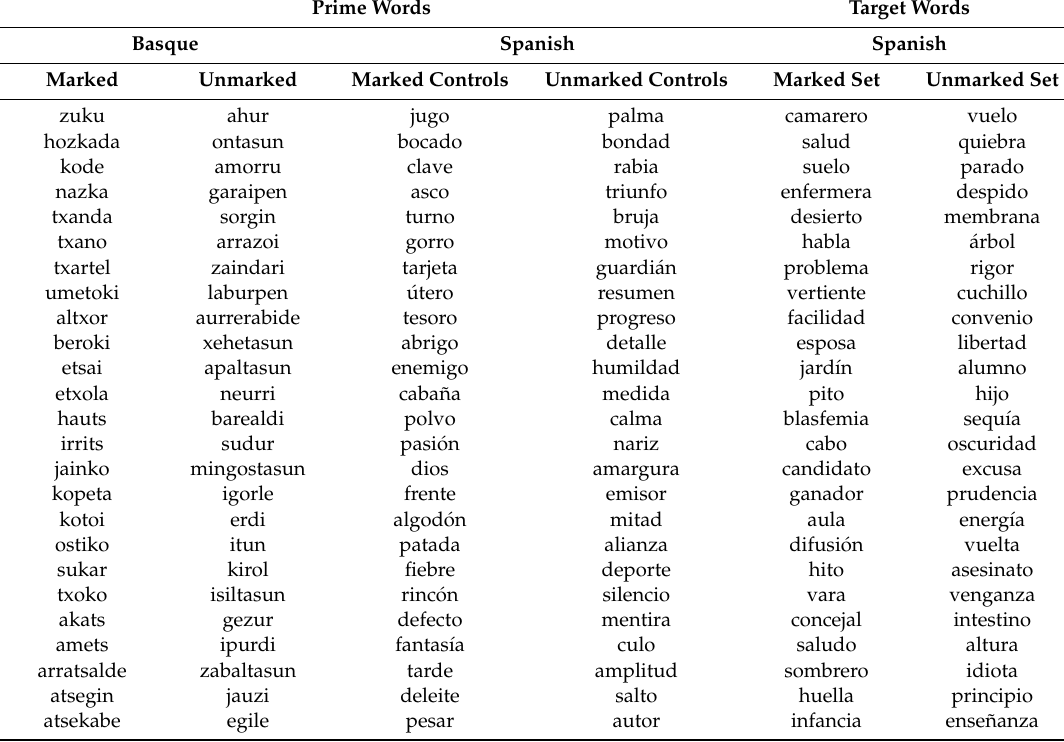
Table A1. Stimuli used in Experiment 1 using the masked language switching priming paradigm with highly proficient Spanish–Basque